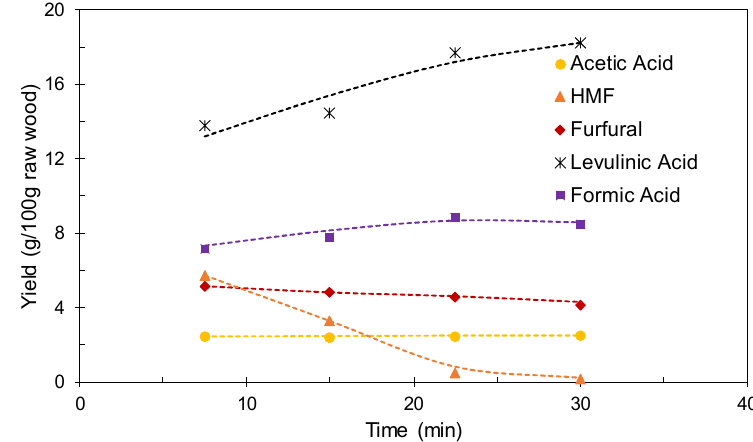
Figure 7. Overall yields (including the contributions of aqueous and organic phases) achieved in experiments performed at 190 °C using [C3SO 3 Hmim]HSO 4 as a catalyst.